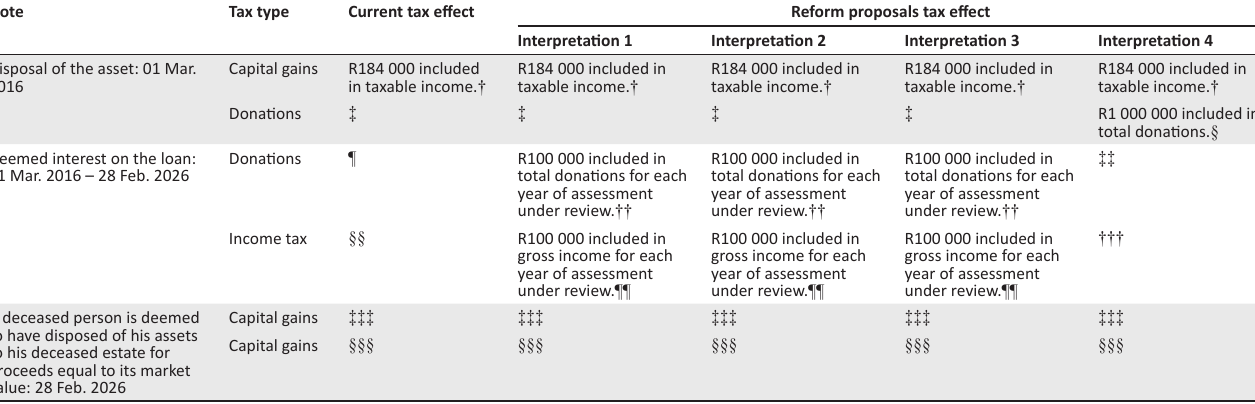
TABLE 1: Tax effect of the scenario on the disposer’s tax calculation: Illustrating the current tax effect and proposed tax effect per tax type on the disposer’s tax calculation per transaction for the given scenario.